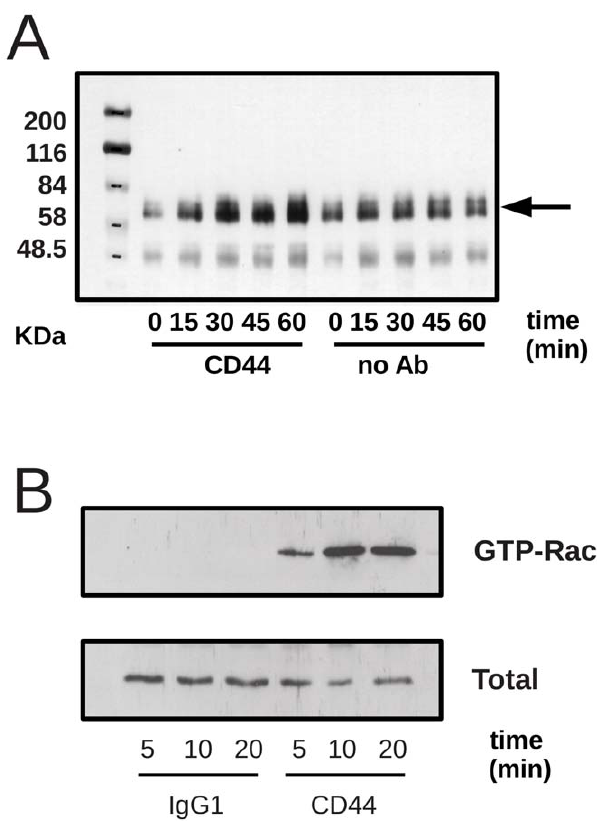
Figure 6. CD44-augmentation of phagocytosis is associated with phosphorylation of paxillin and Rac2 activation. A) Monocyte-derived macrophages were incubated with CD44 mAb at 37 u C for different time points up to 60 min prior to lysis in RIPA buffer. Immunoblot analysis of tyrosine phosphorylation of paxillin revealed a time-dependent increase in phosphorylation following CD44 antibody binding. Image shows representative autoradiograph of a single experiment from 3 that were performed. Densitometric analysis of the phosphopaxillin using ImageJ (http://rsbweb.nih.gov/ij/) confirms increased phosphorylation of paxillin following CD44 treatment. For control phosphopaxillin levels at 0, 15, 30, 45 and 60 min was 7.7, 9.9, 9.3 and 8.2 respectively. In contrast, phosphopaxillin levels following CD44 cross-linking were 3.7, 8.8, 13.7, 12.4 and 15.6 at 0, 15, 30, 45 and 60 min respectively. Molecular weight standards shown in KDa. B) Monocyte-derived macrophages were incubated with either control IgG1 or CD44 mAb at 37 u C for different times up to 20 min prior to lysis in RIPA buffer as indicated. Pull down assays using PAK CRIB agarose beads revealed a robust increase in GTP-bound Rac2 in the presence but not absence of CD44 antibody binding. A representative autoradiograph from a single experiment (from 5 that were performed) is shown.